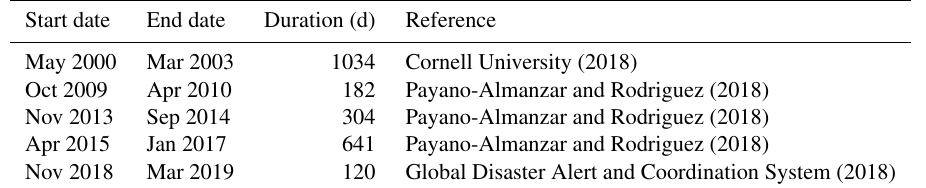
Table A2. Past drought events in the Dominican Republic over the period from 2000 to